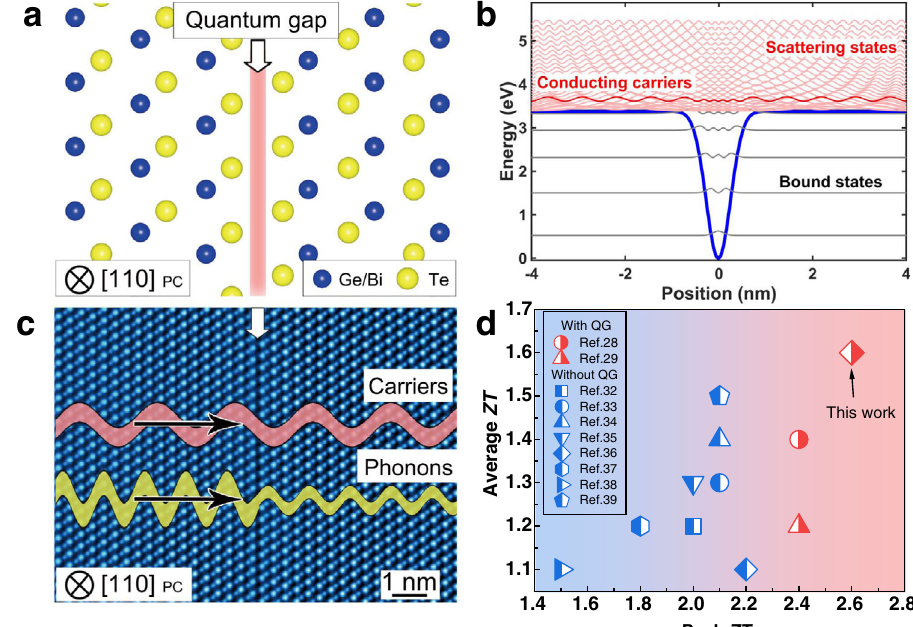
Fig.1|QuantumgapsandtheirroleinimprovingtheperformanceofGe – Bi – Te alloys.a ThestructuralmodelofaQGinGe – Bi – Tealloyviewedalong[110] PC zone axis. b The experimental quantum well and calculated quantum states at the QG area. c AsketchofthetransportpropertyofQG,whichallowscarrierstofreelypass